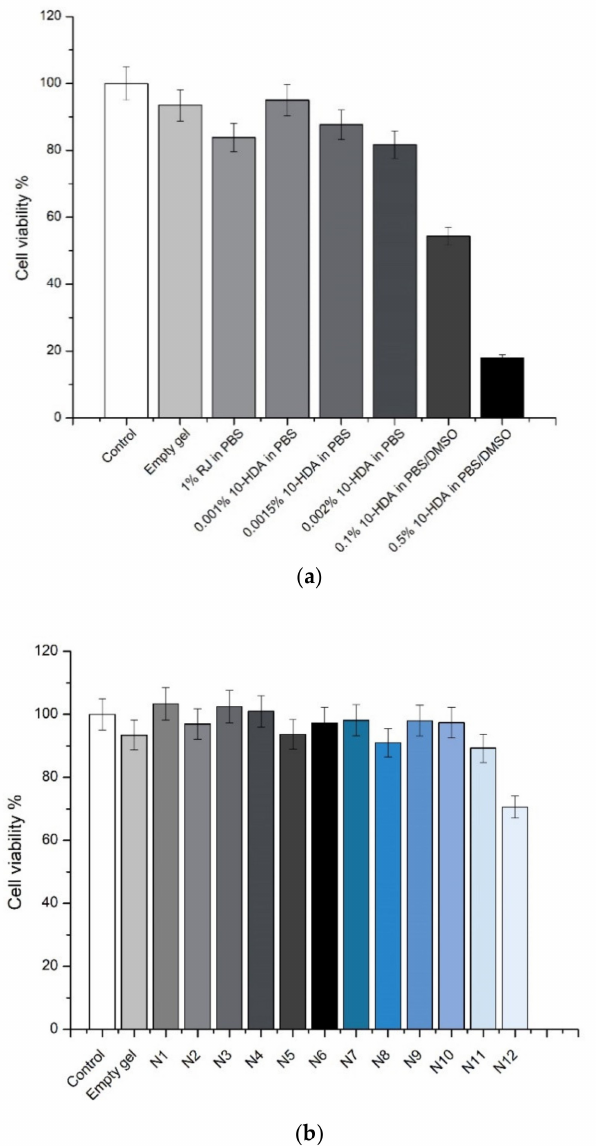
Figure 6. The STE test results after 30 min of exposure to RJ and 10-HDA solutions ( a ) and all in situ gels ( b ). Data represent mean standard deviation (SD), n =